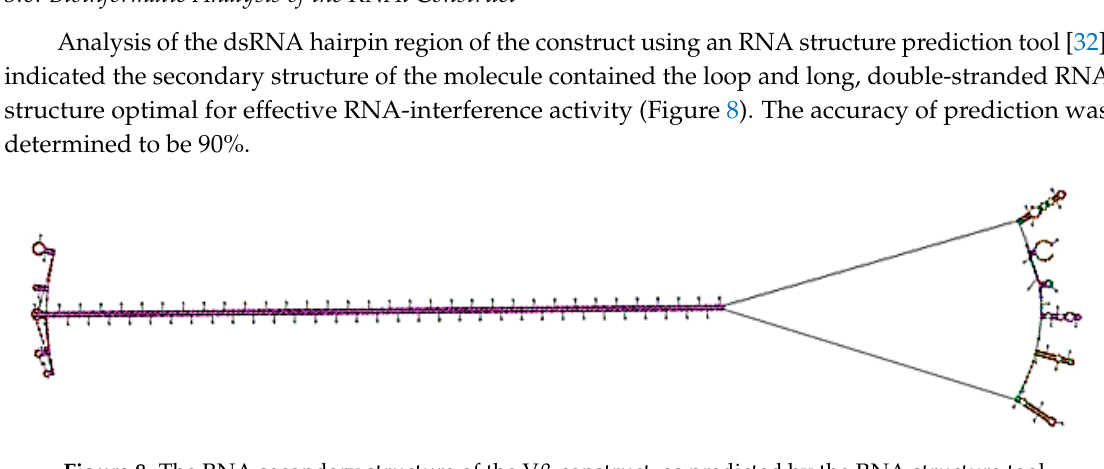
Figure 8. The RNA secondary structure of the V β construct, as predicted by the RNA structure tool.